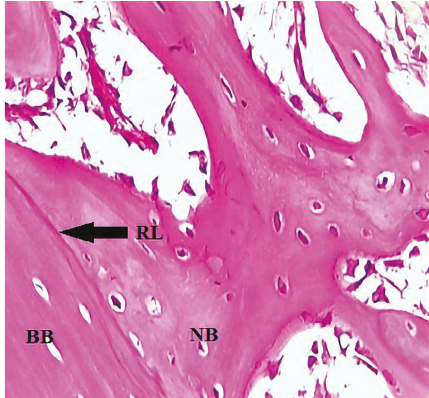
Figure 1: A view of the defect site in the C group shows a reversal line (RL), basal bone (BB), and new bone (NB) (arrow) after 2- weeks. H&E x40.